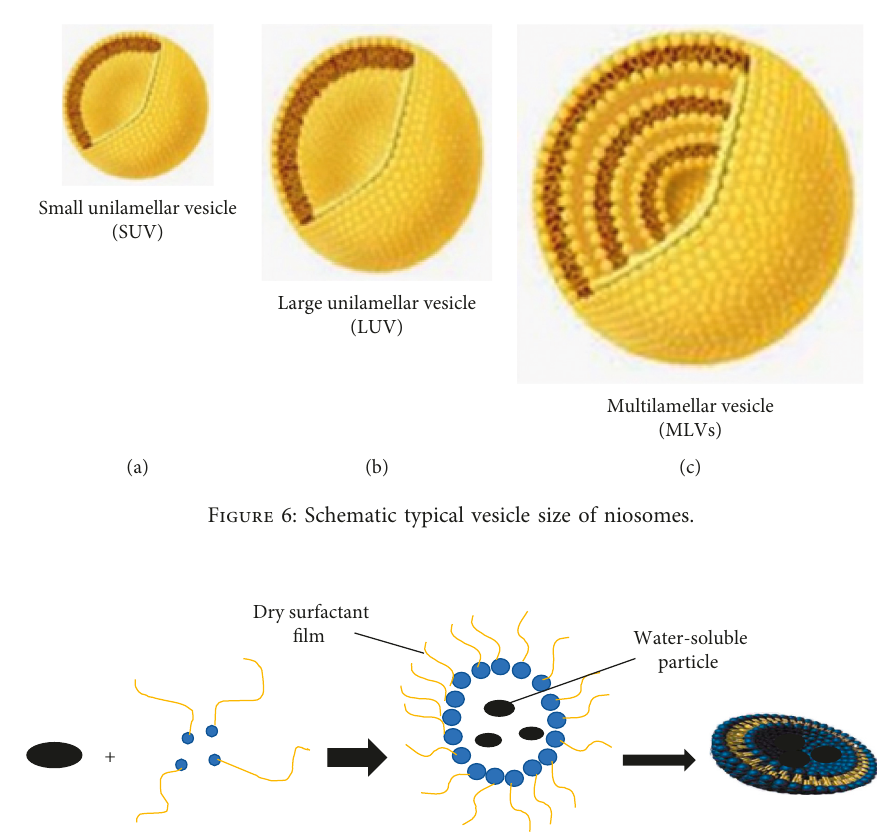
Figure 7: Schematic proniosome and niosomes formation process.